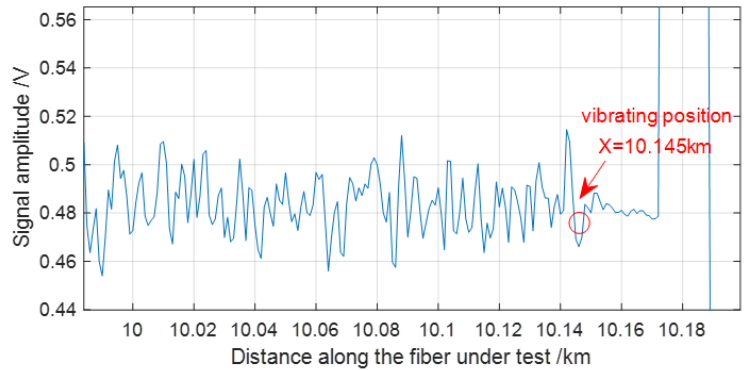
Figure 6. The averaged OTDR trace with a vibration event at 10.145 km.